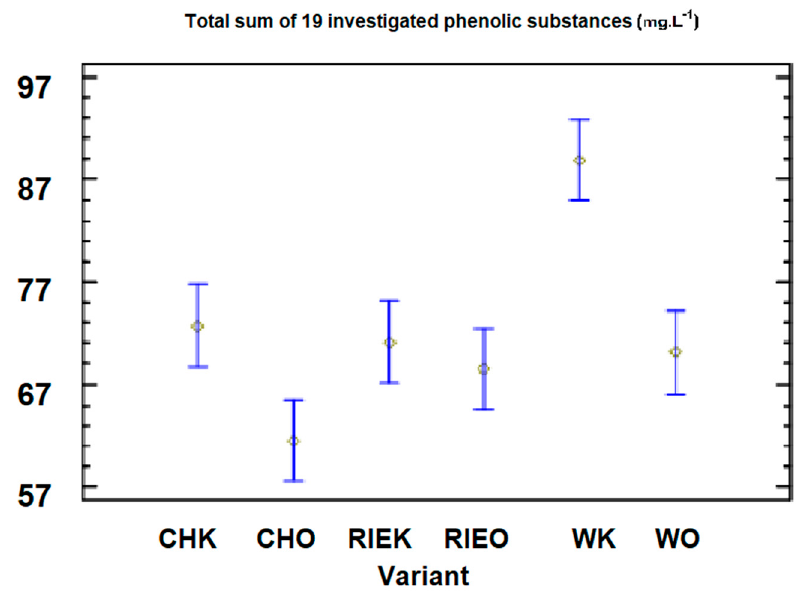
Figure 1. Graphic representation of the 95% confidence intervals of the sum of 19 monitored phenolic substances for the tested averages from individual varieties and variants in 2015. Table 9. Influence of the variant on the total content of 19 monitored phenolic substances in wine in 2015 and 2016.